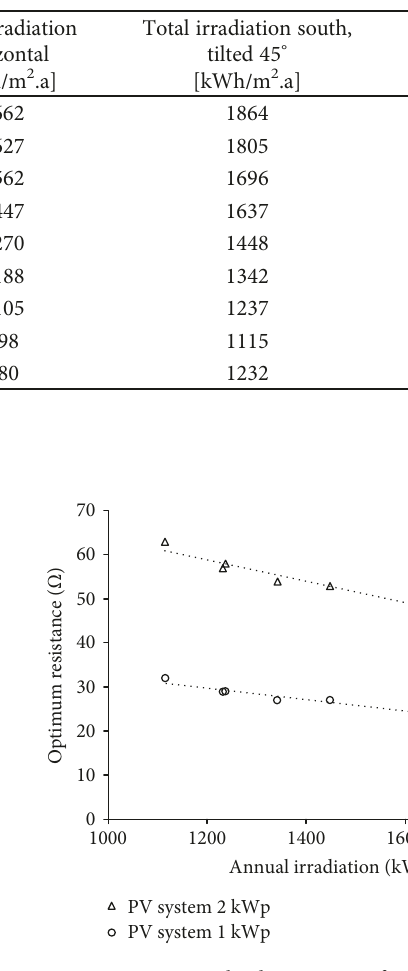
Table 2: Climate characteristics for selected locations.